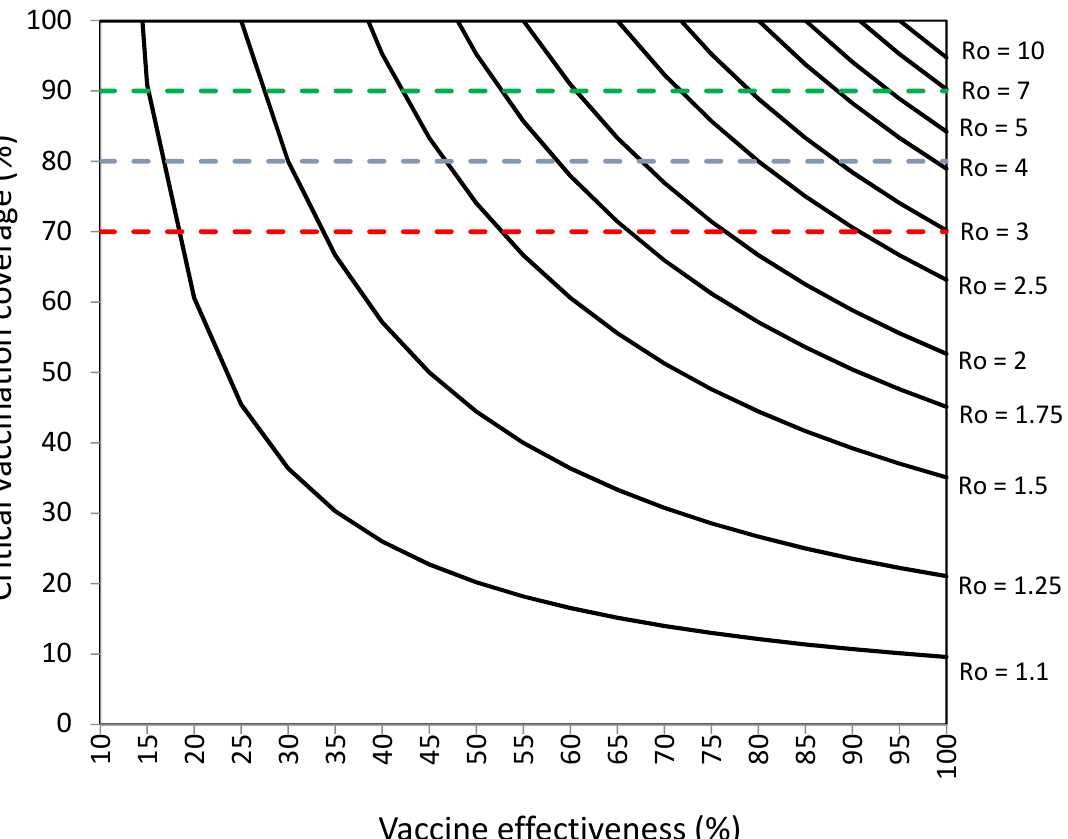
Figure 3. Vaccination coverage (%) required to establish herd immunity against SARS-CoV-2 with different reproductive numbers (R o ) by vaccination effectiveness (%) in a population with 5% of infections among vaccinated individuals. Objectives of vaccination coverage of 70%, 80%, and 90% are indicated with dashed red, blue, and green lines, respectively.